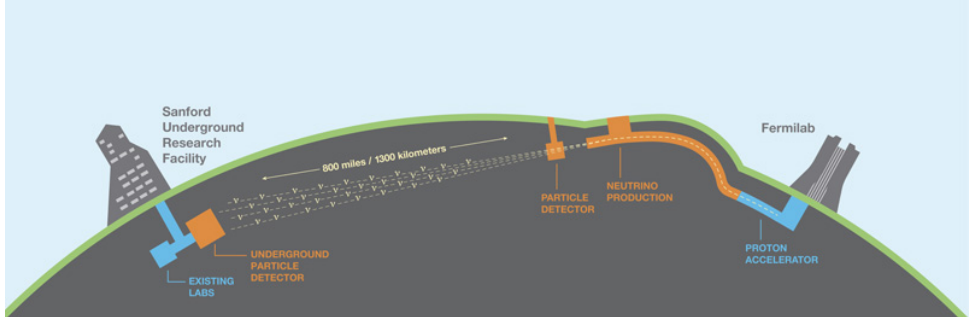
Figure 6. Cartoon illustrating the configuration of the LBNF beamline at Fermilab, in Illinois, and the DUNE detectors in Illinois and South Dakota, separated by 1300